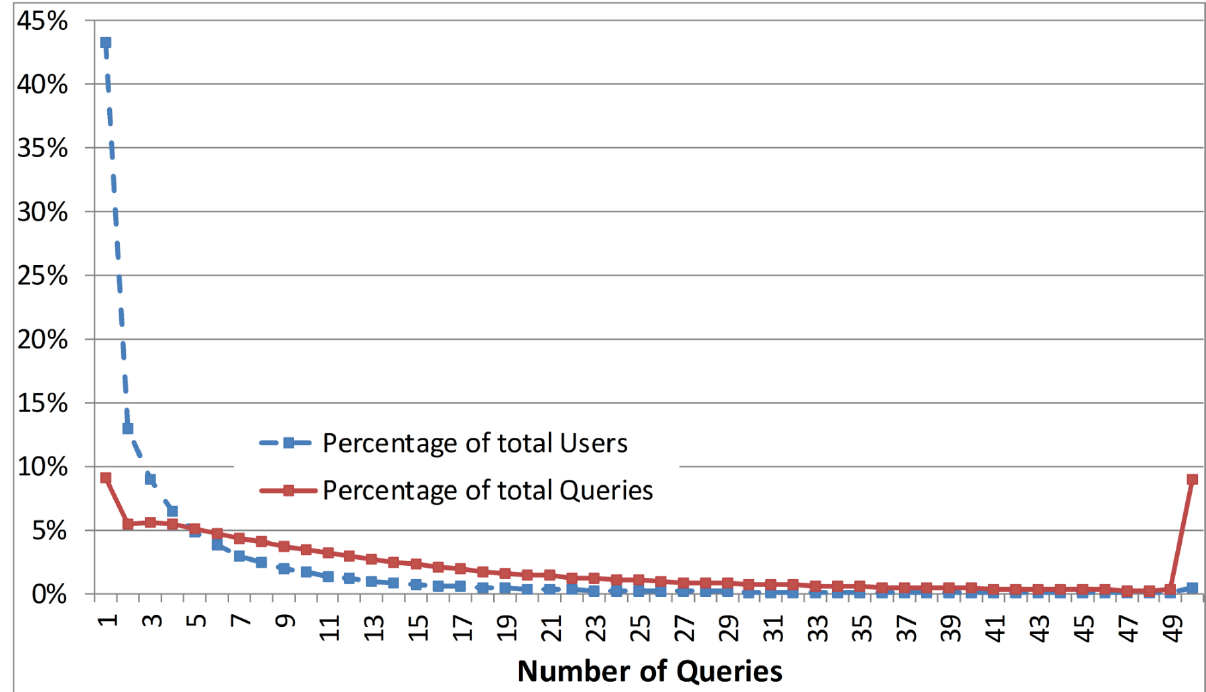
Figure 3. Percentage of users and queries per number of